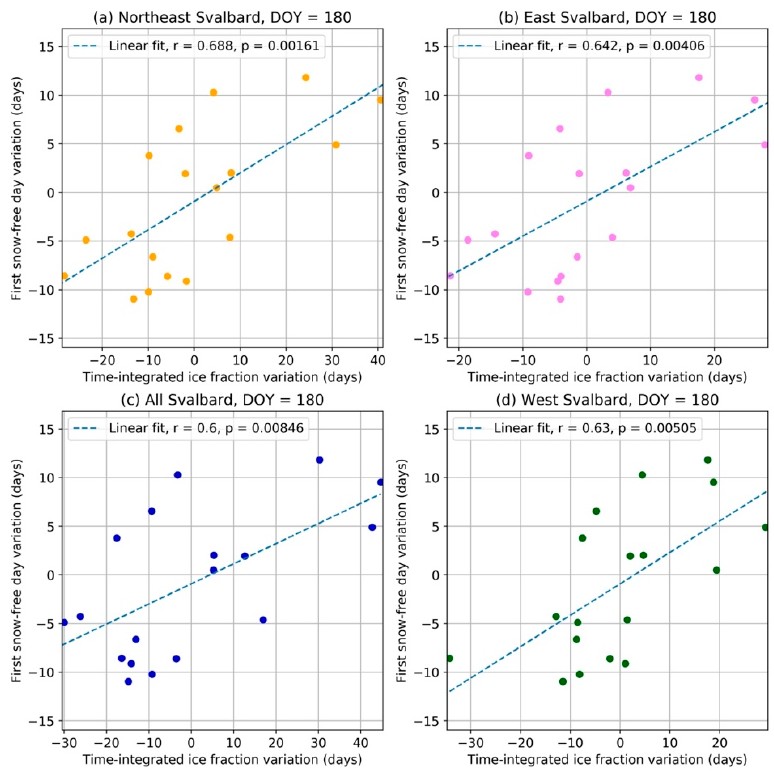
Figure 15. Scatterplots showing the relationship between detrended TI-SIC and FSFD variations averaged over Nordaustlandet, using the TI-SIC time series that gave the highest correlation with the detrended FSFD time series for the four sea ice regions ( a ) Northeast Svalbard ( b ) East Svalbard ( c ) All Svalbard and ( d ) West Svalbard. Values of maximum correlation (r) and p-values are stated in the legend. The day of year associated with maximum correlation between TI-SIC and FSFD is also stated.